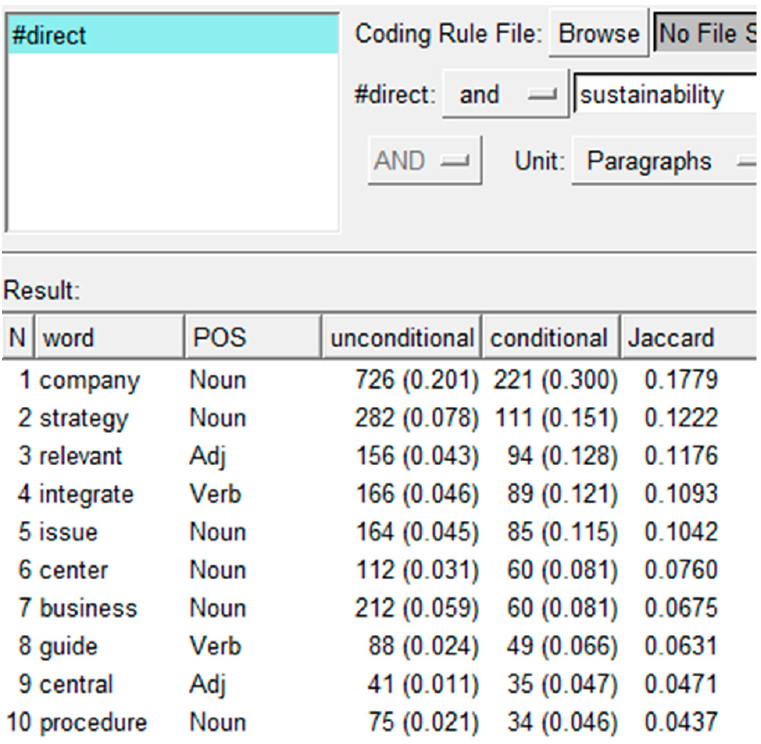
Figure 6. Sustainability word association.